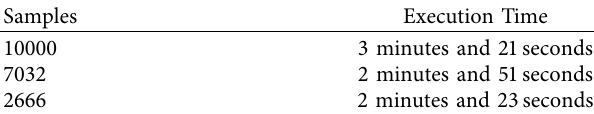
Table 13: Samples and execution